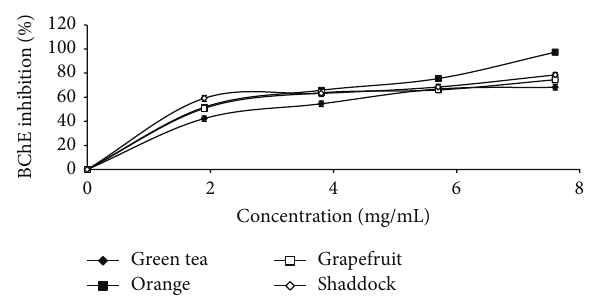
Figure 2: Butyrylcholinesterase inhibitory activity of infusions of green tea and some citrus peels. Values represent means ± standard deviation of triplicate readings.